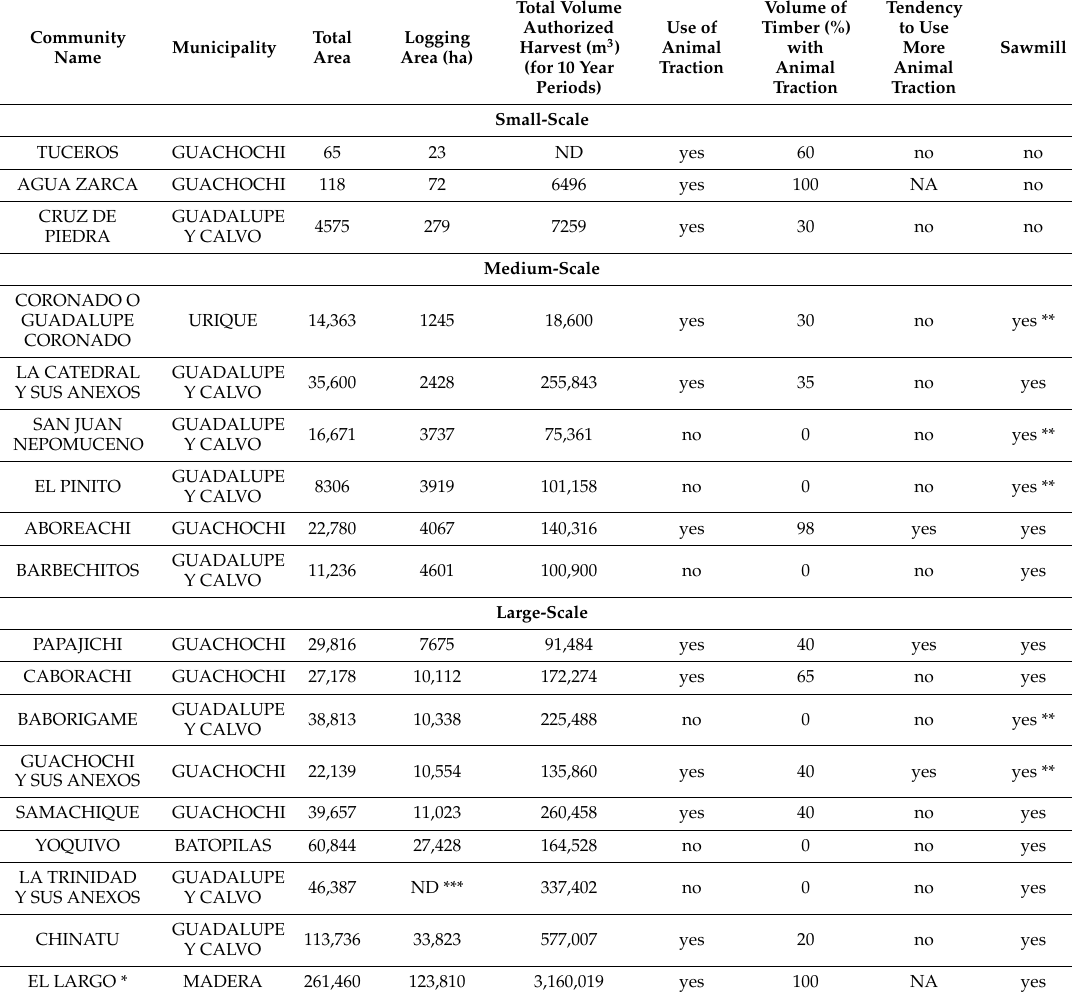
Table 1. Community forest enterprises in Chihuahua by scale ( n = 17 + 1 purposeful